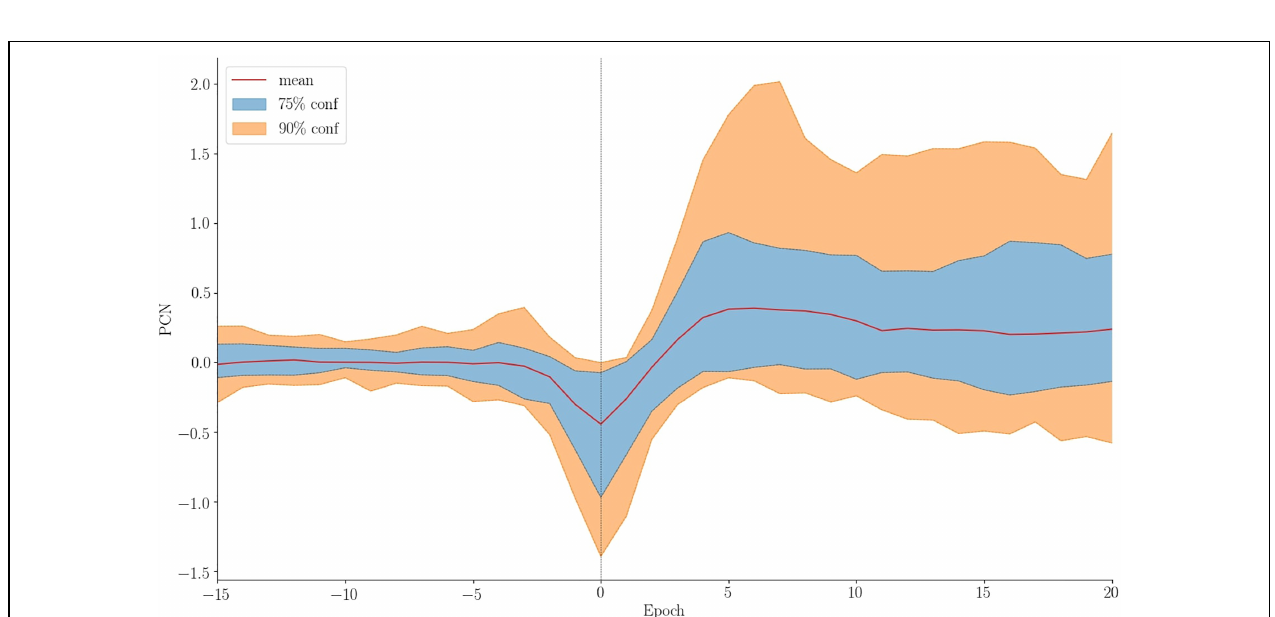
FIGURE 9 | Superposed epoch analysis of the low/mid latitude response to rapid increases in P d using the SMR index. The solid lines indicate the mean of SMR and its local time components. The dashed grey lines indicate the 25 and 75% percentile. The SMR time series for each event has been scaled with respect to the increase in √ P d and a baseline prior to onset subtracted. The number in each window indicates the number of events in each group.